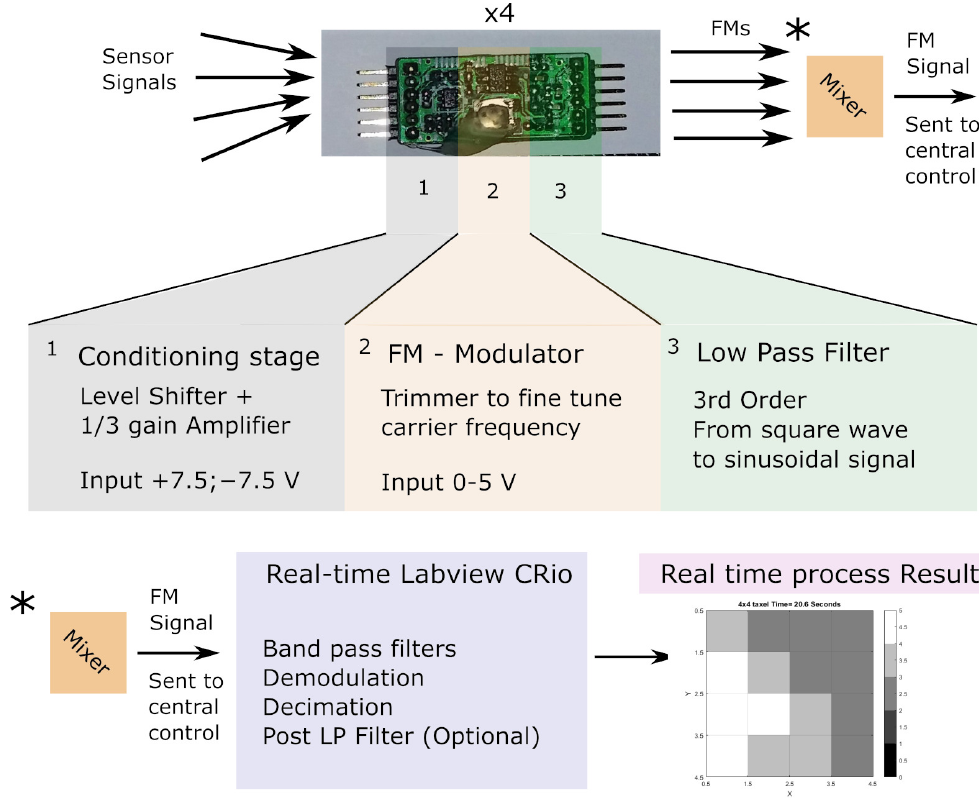
Figure 4. Diagram of the encoding board and the demodulation process. From top left to right encoding and bottom left to right decoding and taxel output. The asterisk (*) indicates the equivalent point in the modulation ( top ) and demodulation ( bottom )